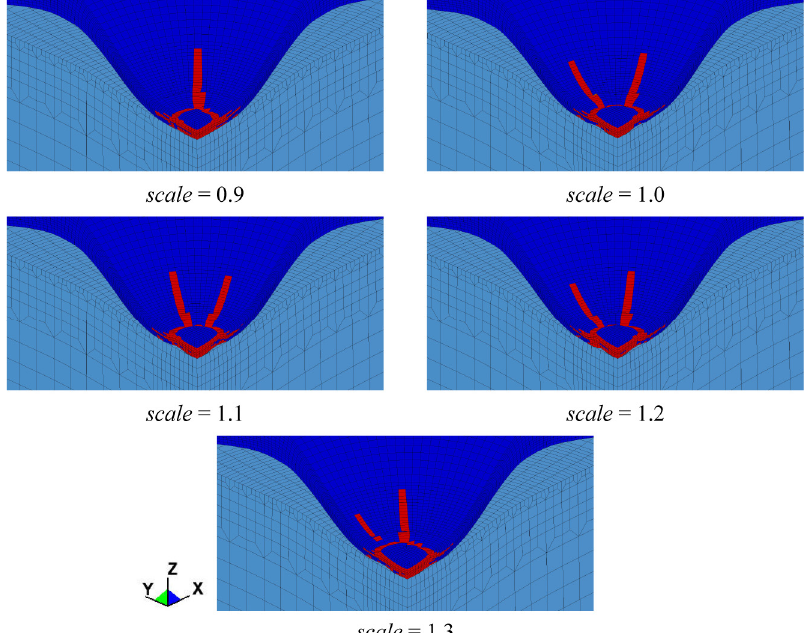
Figure 19. Final failure patterns of automotive coatings with different yield strengths of primer.